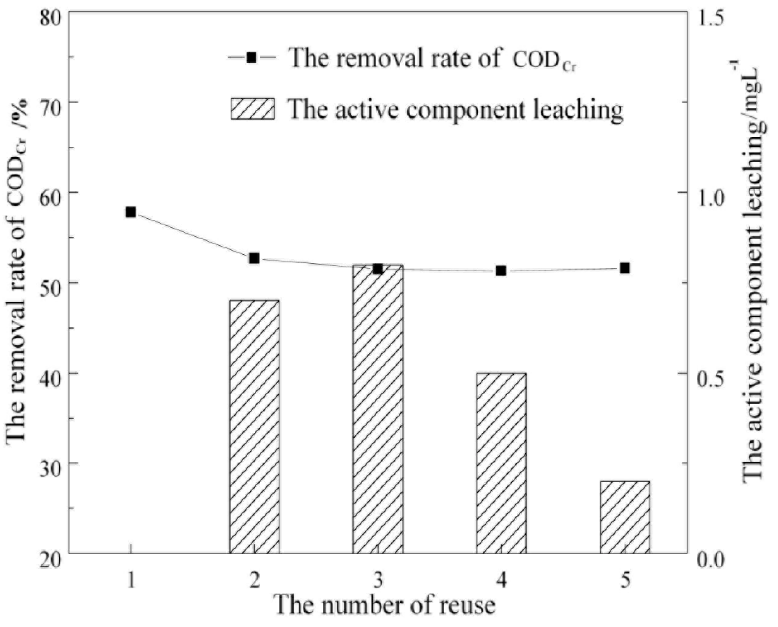
Figure 12. COD Cr removal efficiency and metal ions leaching during catalyst recycling.